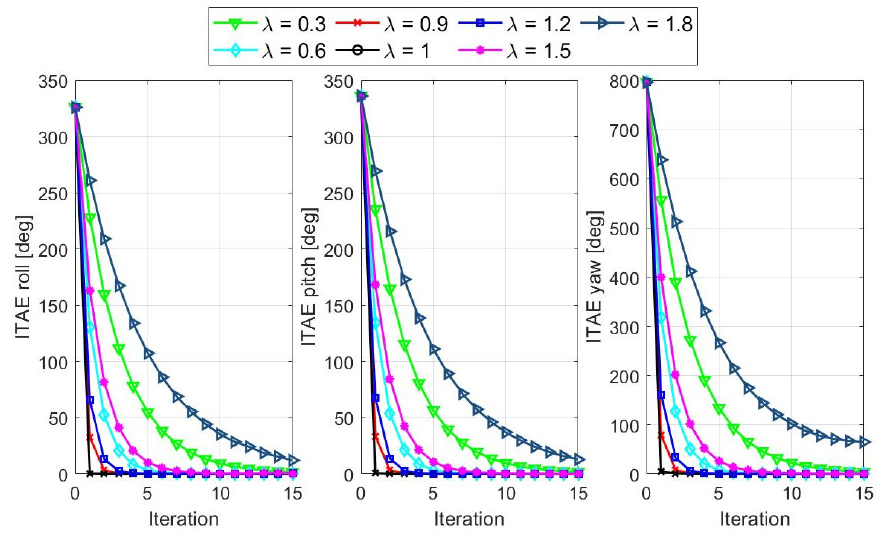
Figure 7. ITAEs of the tracking errors after each iteration.